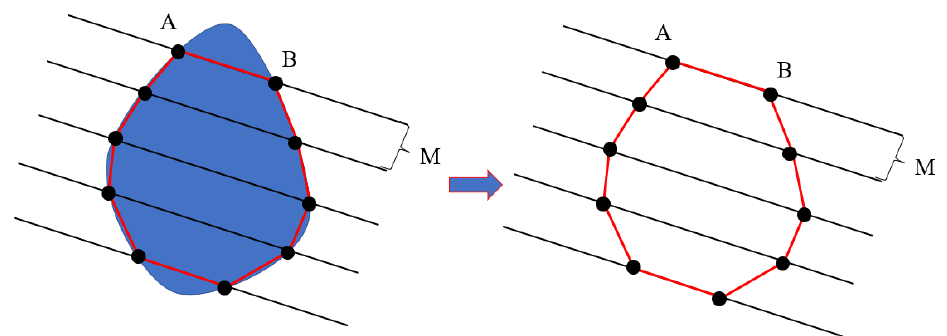
Figure 14. Schematic diagram of irregular defect. Five equidistant black lines are used to divide the area of irregular defect. A red broken line is extracted to replace the irregular defect profile.